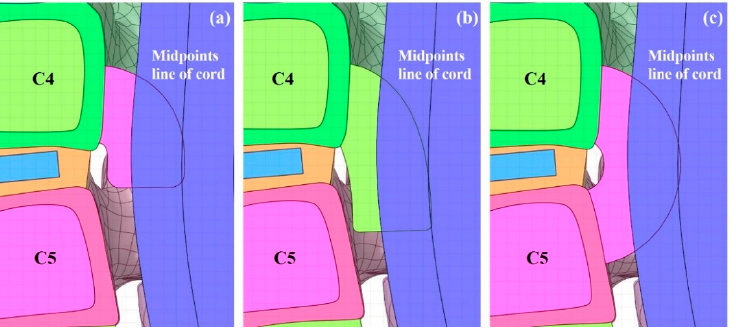
Figure 2. Three-dimensional OPLL model: ( a ) type 1 OPLL: covered disc; ( b ) type 2 OPLL: covered vertebra; and ( c ) type 3 OPLL: connected vertebra.